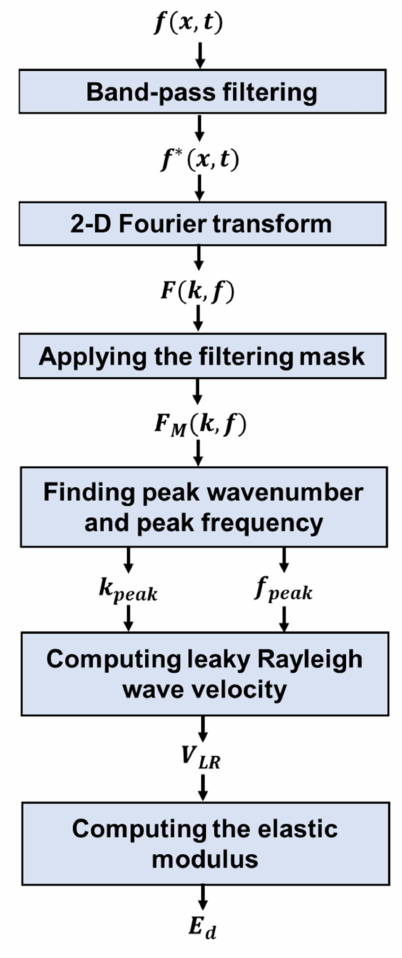
Figure 4. A flowchart of the proposed signal processing